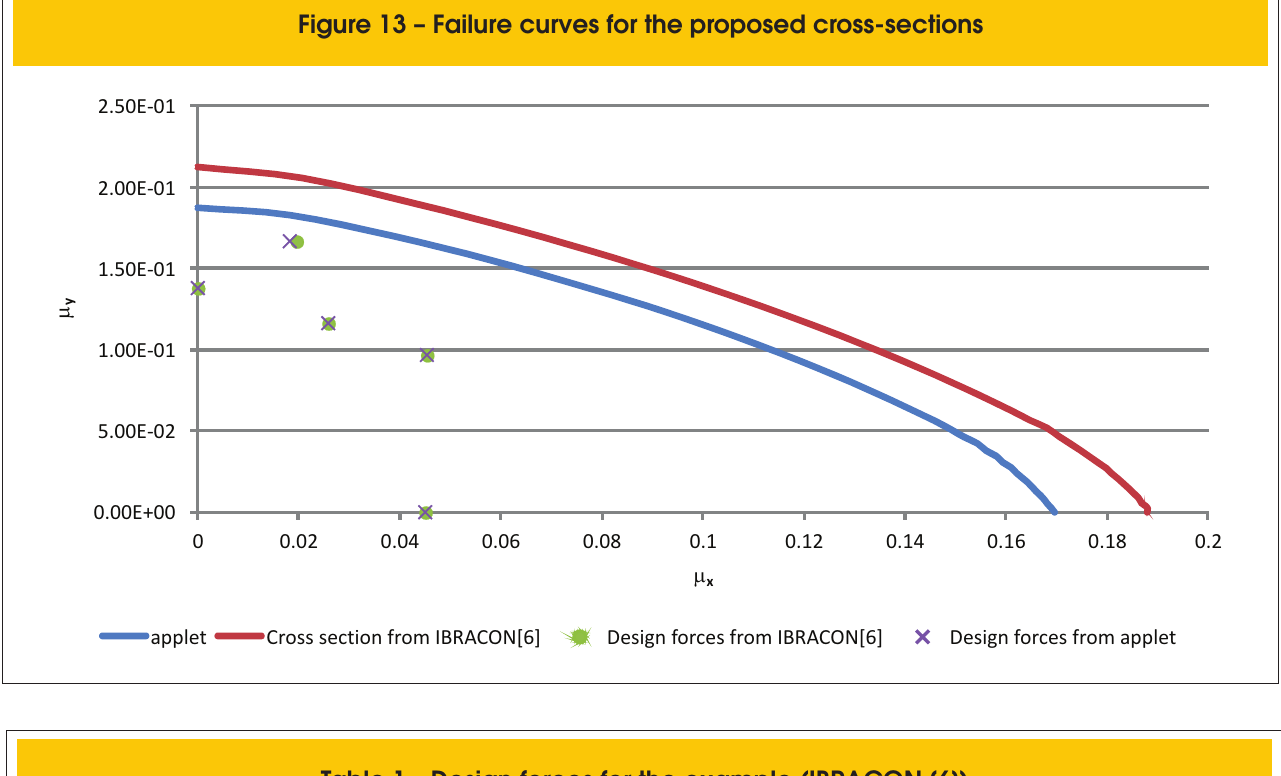
Table 1 - Design forces for the example (IBRACON [6])